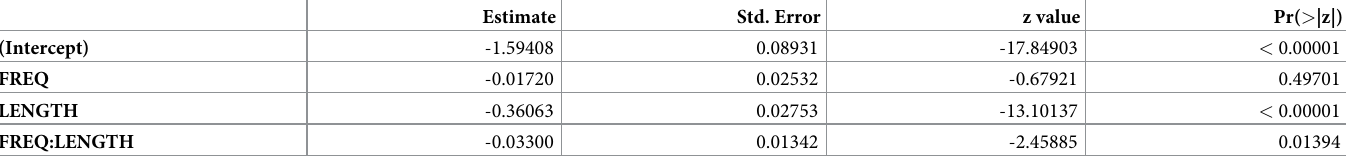
Table 2. Fixed effects of optimal GLMM (Model 1) for the probability of skipping the test words.